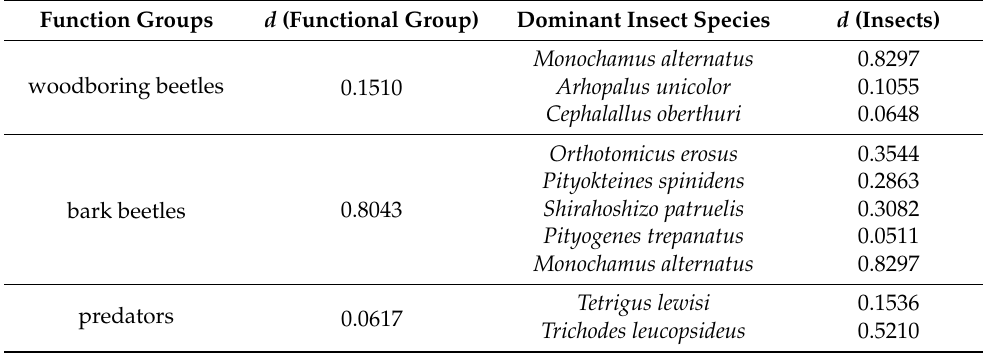
Table 2. Function groups of insects and their dominance index ( d ) in P. massoniana Lamb. Function Groups